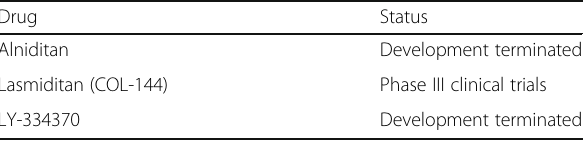
Table 1 Overview of ditans in alphabetical